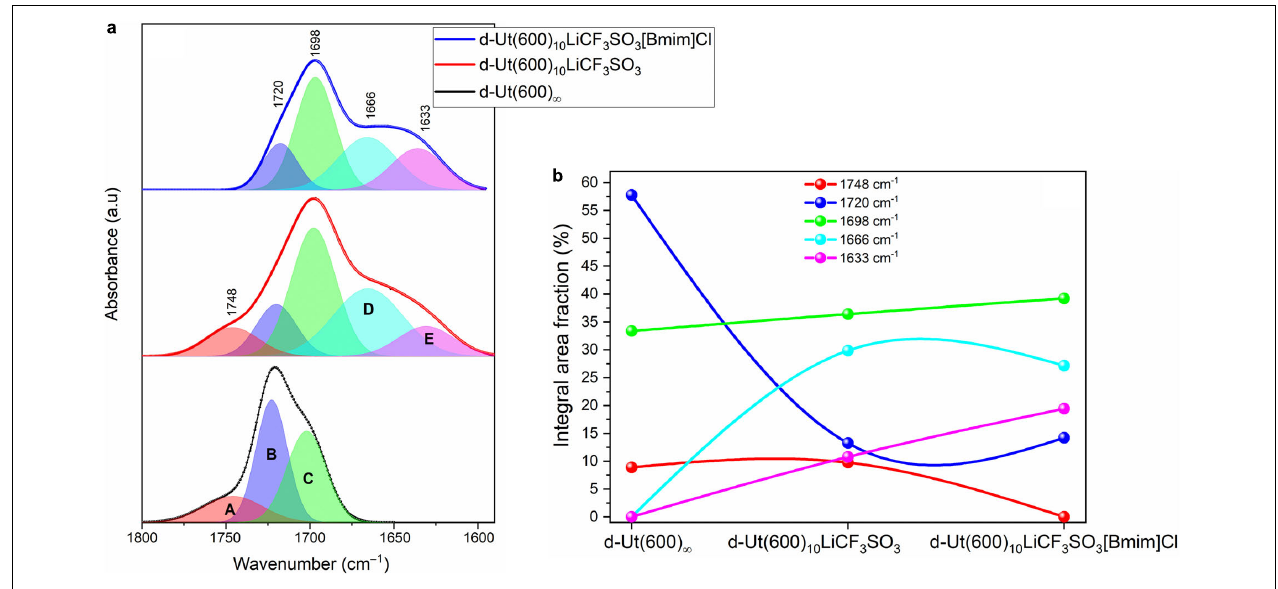
FIGURE 3 | Curve-fitting results (a) of the FT-IR spectra in the “amide I” region of d-Ut(600) ∞ (black line), d-Ut(600) 10 LiCF 3 SO 3 (red line) and d-Ut(600) 10 LiCF 3 SO 3 [Bmim]Cl (blue line). Integral area fraction (b) of the “amide I” bands of the d-Ut(600) ∞ , d-Ut(600) 10 LiCF 3 SO 3 and d-Ut(600) 10 LiCF 3 SO 3 [Bmim]Cl. The lines are a guide for the